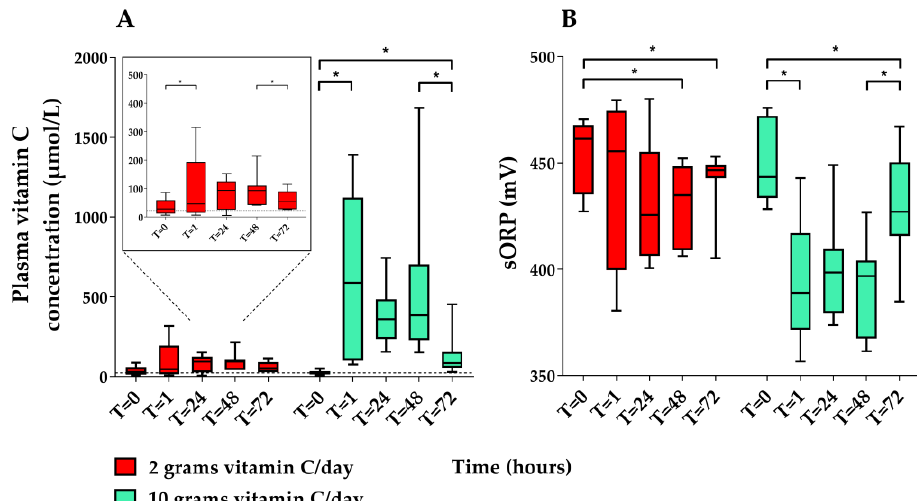
Figure 4. Boxplots of plasma vitamin C concentrations ( A ) and static oxidation reduction potential (sORP) ( B ) in the pharmacokinetic study at five different time points (hours). The dashed line ( A ) represents the lower limit of normal plasma vitamin C concentrations (23 µmol/L). Asterisks represent significant differences at p < 0.05. Vitamin C concentrations at T24 and T48 are trough concentrations. T72 represents a wash-out phase sample. sORP was measured in acidified samples.